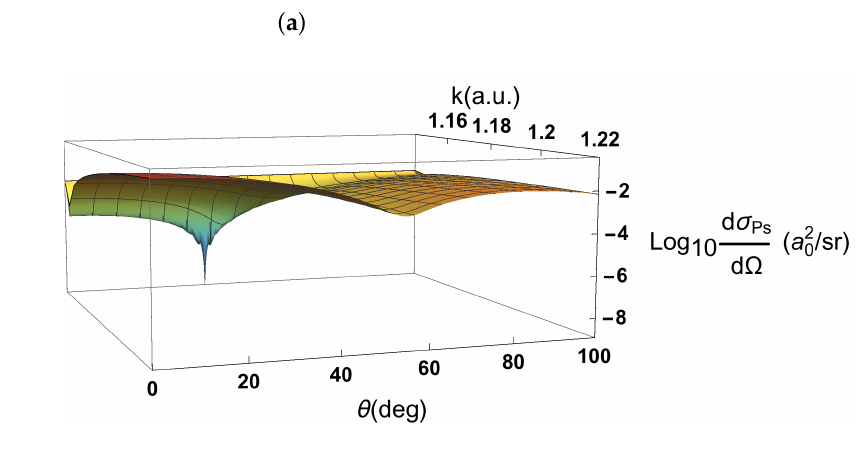
Figure 2. The common logarithm of the Ps-formation differential cross section, log positron–helium collisions as a function of k and θ . ( a ) Shows the k range of most of the Ore gap and for the θ range from close to zero to 100 ◦ . ( b ) Shows a different rotation for the same k range and for the θ range from the 0 ◦ to 100 ◦ . Table 1. Position of the zero in f Ps , ( k 0 , θ 0 ) & ( κ z 0 , κ x 0 ) , which we compute using the complex